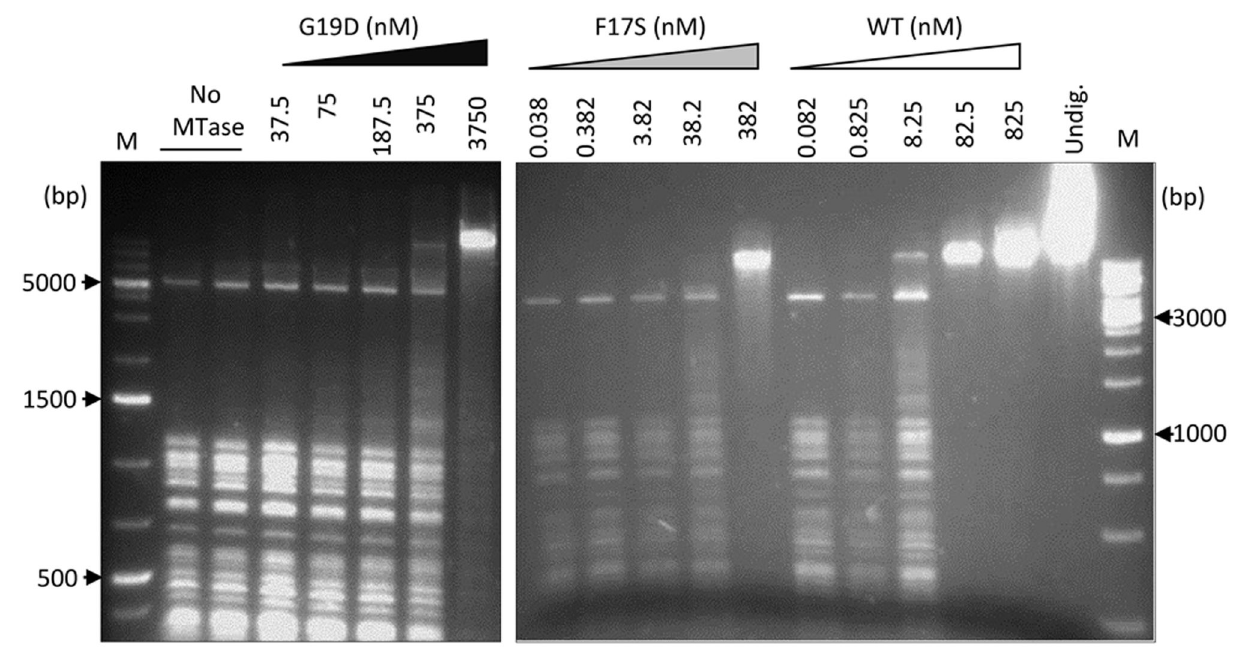
Figure 3. Estimation of DNA MTase activity of the F17S and G19D M.SssI mutants by restriction enzyme protection assay. Lambda phage DNA was incubated with different concentrations of WT and mutant M.SssI in the presence of SAM as described in Materials and Methods. Methylation status of the DNA was subsequently tested by digestion with the methylation sensitive restriction enzyme Hin6I, and the digestion was analyzed by agarose gel electrophoresis. Lane Undig., undigested plasmid; M, molecular weight marker (GeneRuler 1 kb Plus and GeneRuler 1 kb DNA Ladders, Fermentas). M.SssI-mediated cytosine deamination in vivo was initially investigated using a two-plasmid-system, with the E. coli host containing the indicator plasmid pUP41 and one of the M.SssI-expressing plasmids pSTdC-MSssI, pSTdC-MSssI(F17S) or pSTdC- MSssI(G19D). The latter plasmids have pSC101 replicon and are compatible with pUP41. We observed elevated reversion frequency to kanamycin resistance with the Ung - host ER2357 expressing the G19D variant (not shown). doi: (Figure 5). If SAM was present, 5’-amino-5’-deoxyadenosine had no effect (Figure 1).